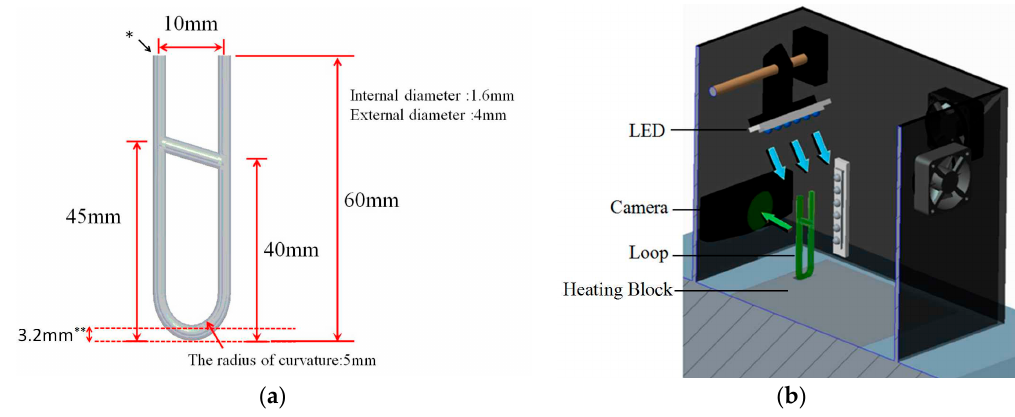
Figure 1. ( a ) Physical dimensions of the glass capillary loop; ( b ) schematic diagram of the detection setup. * the place of reagent injection; ** the depth of heating groove. Blue arrow: excitation light; Green arrow: emission light.